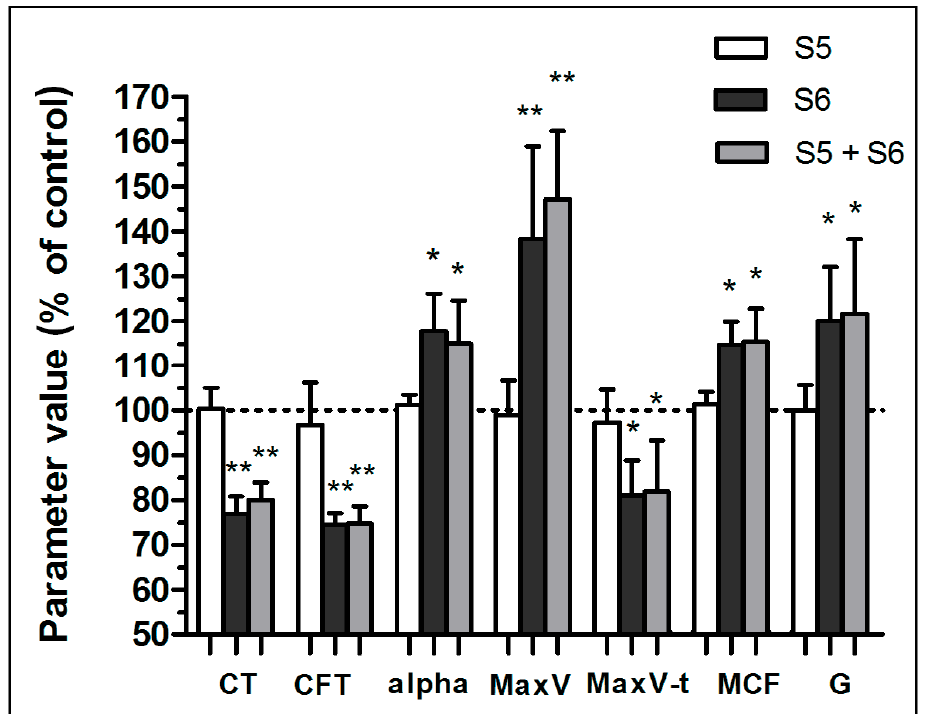
Figure 2. Verification of the interaction effect of fractions S5 (100 µ g/mL) and S6 (300 µ g/mL) on procoagulant activity. Parameters associated with clotting initiation (CT, clotting time; CFT, clot formation time), propagation (alpha angle; MaxV, maximal velocity of clot formation; MaxV-t, time to reach maximal velocity of clotting), and stabilization (MCF, maximum clot firmness; G, shear elastic modulus strength) were measured. Data are means ± SD from n = 7 experiments, * p < 0.05; ** p < 0.01.